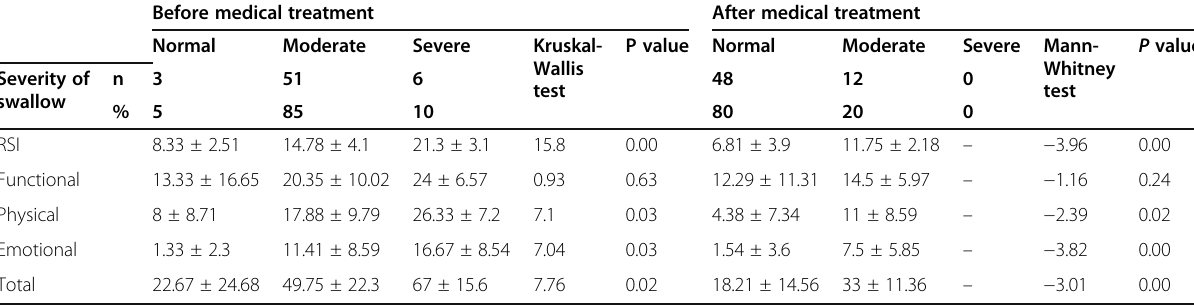
Table 4 RSI and DHI by severity of swallowing before and after medical treatment Before medical treatment After medical